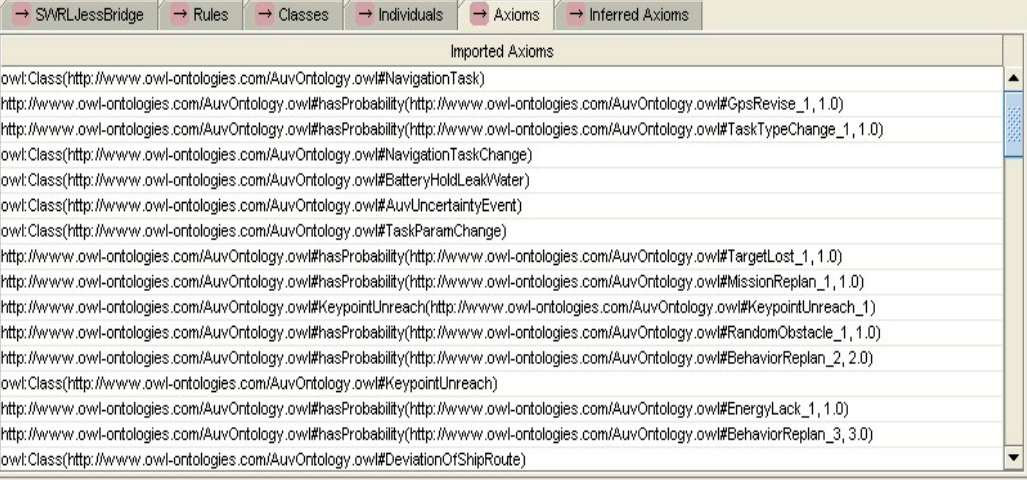
Figure 5. Experimental axioms for event detection inference based on SWRL rules.